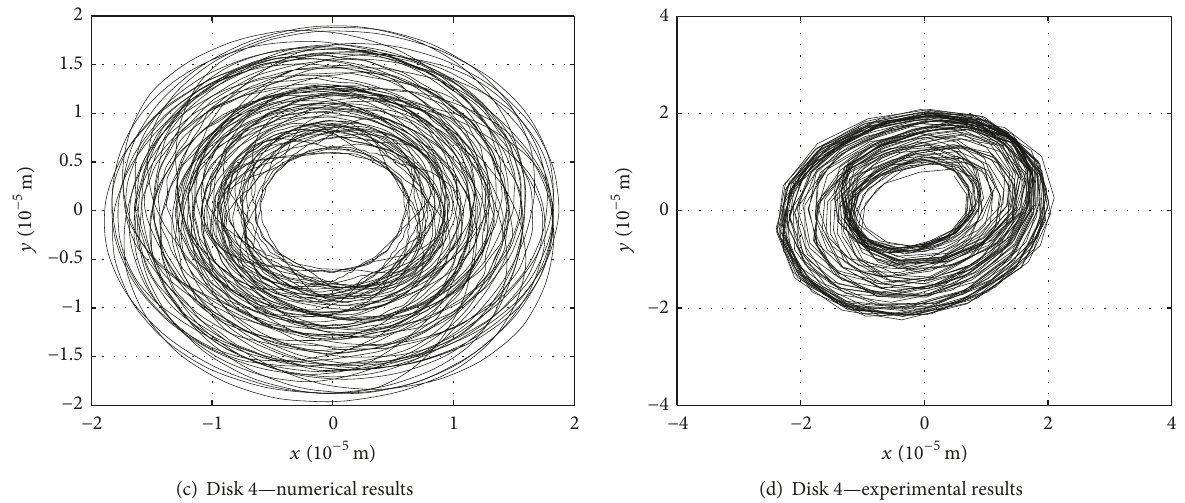
Figure 21: Orbit of disk 2 and disk 4 with 𝜔 1 = 146 rad / s and 𝜆 = 1.65